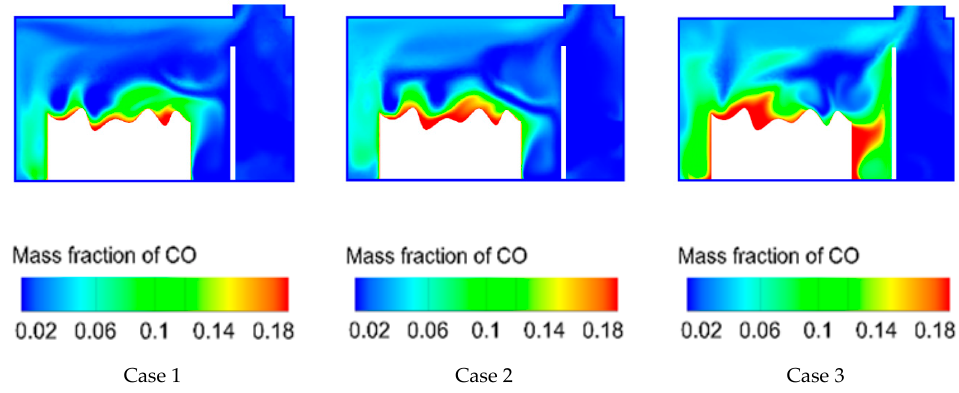
Figure 8. Mass fraction of carbon monoxide (CO) for different mass flow rates of the cooling air.